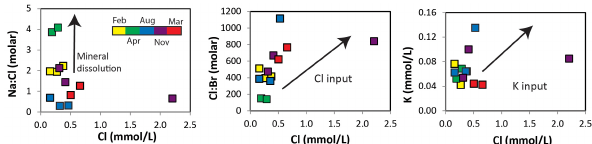
Figure 6. Trends in major ion chemistry at Bruthen indicating min- eral dissolution, the input of Cl into groundwater and the input of K into groundwater.